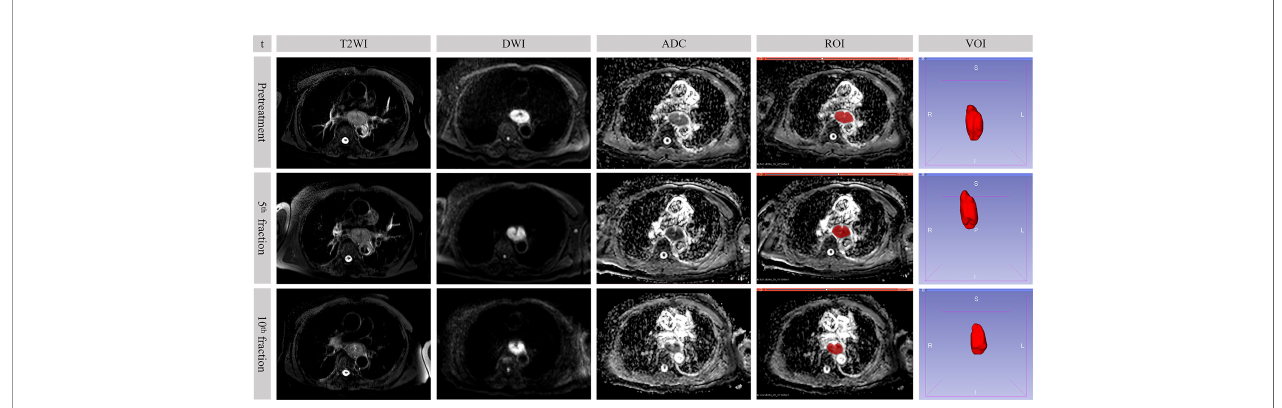
FIGURE 2 | Sequential MR images in a 73-year-old male who underwent concurrent chemoradiotherapy with partial response. The value of b -factor of DWI in the fi gure was 600 s/mm 2 . t, time point; DWI, diffusion-weighted imaging; ADC, apparent diffusion coef fi cient; ROI, region of interest; VOI, volume